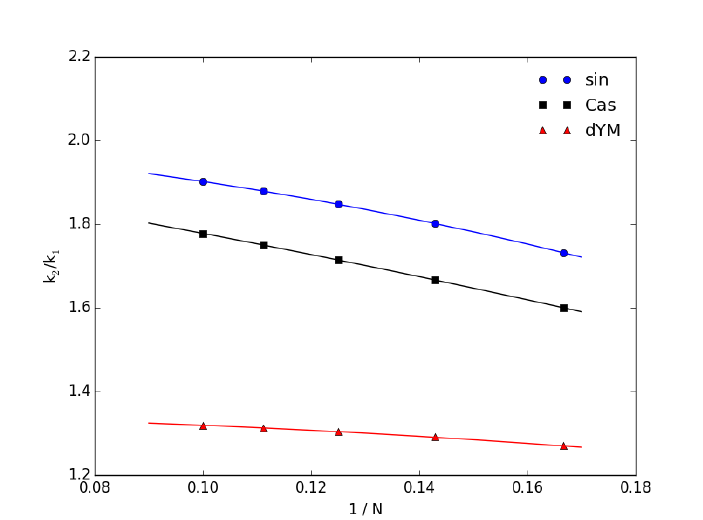
Figure 5 . Polynomial (cid:12)ts for T 2 =T 1 k -string ratios in dYM and noised ( Casimir for SU(6 dYM: 1 : 345 + 0 : 035x